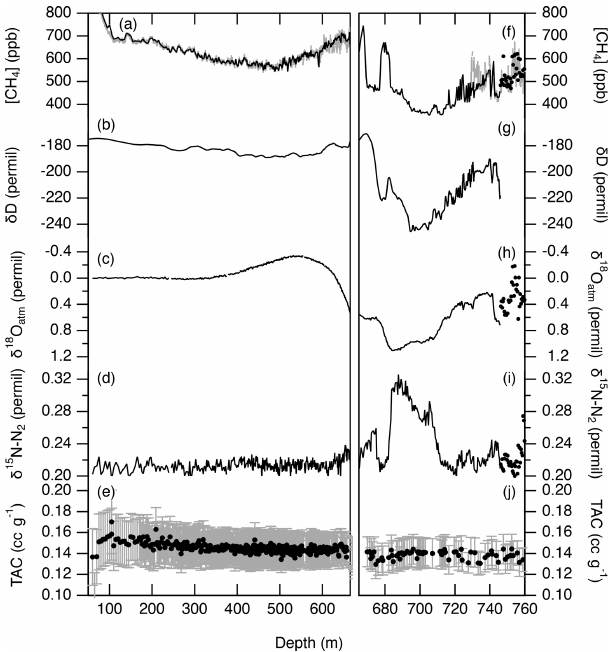
Figure 2. Data from the RICE ice core. Left panels (a–e) (60– 665m) cover the last 11.26ka; right panels (f–j) (665–760m) cover measurements from 11.26 to 83ka and measurements from the 9m of ice below the dated section. (a, f) Continuous methane mea- surements, gray, between 0 and 726m depth are calibrated to dis- crete methane measurements, black. Beyond 726m depth, raw CFA methane measurements are plotted. (b, g) Continuously measured δ D smoothed with a 500-year LOESS filter and subsampled at 50- year spacing. (c, h) δ 18 O atm measurements are corrected for gravi- tational enrichment in the firn layer using δ 15 N-N 2 (d, i) . (e, j) To- tal air content (TAC) was measured in conjunction with discrete